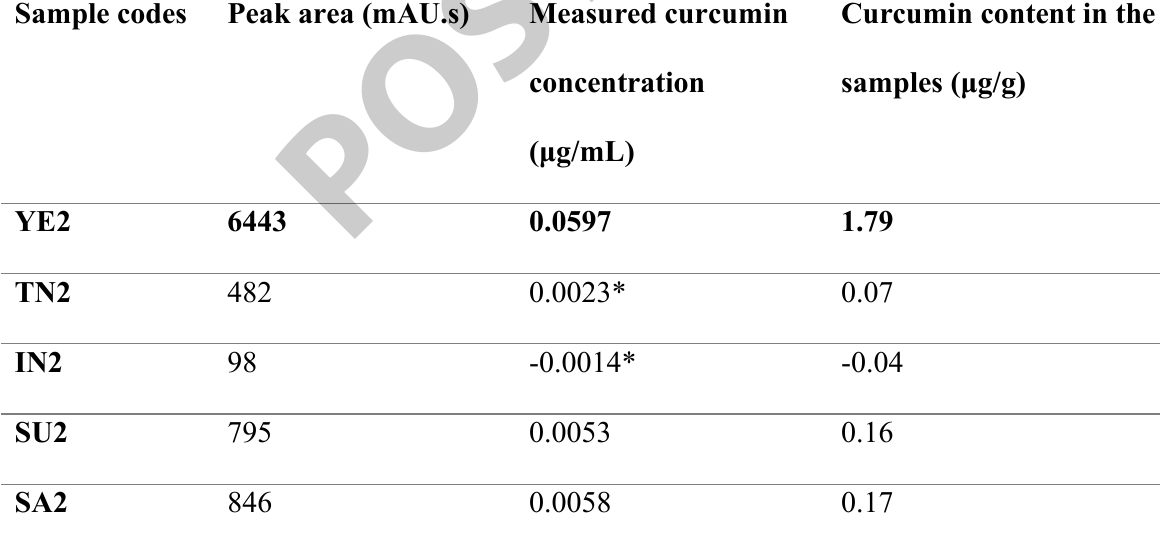
Figure 4. Standard line and the linear regression model of curcumin concentration (µg/mL) and peak area (mAU.s) Table 9. Curcumin accumulation in five different samples after four months of culture Sample